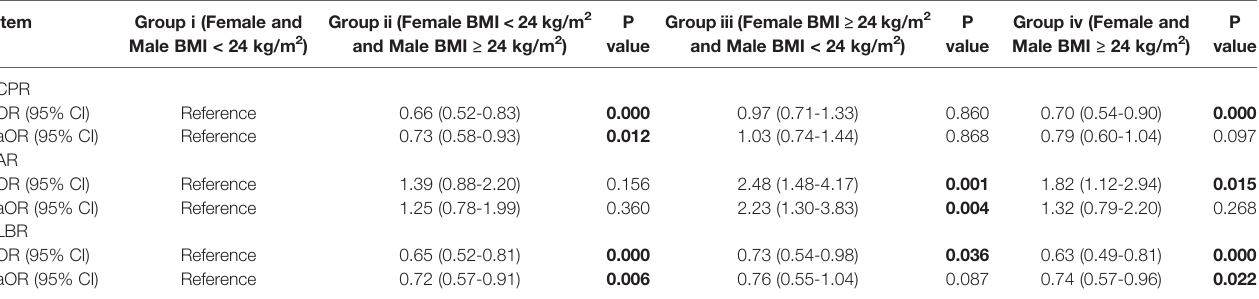
TABLE 4B | Logistic regression analysis on the effect of female and male BMI on pregnancy outcomes in ICSI cycles. Item